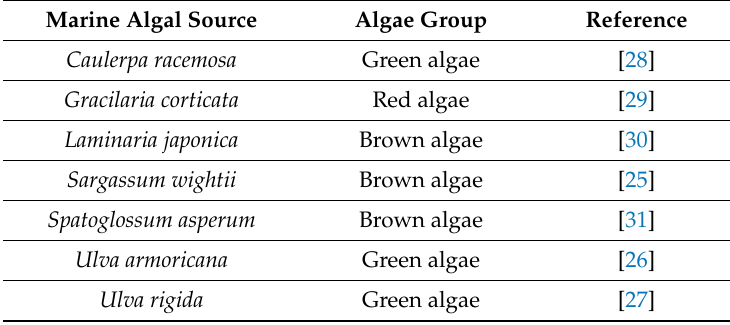
Table 3. Marine algae source with antibacterial activity attributed to